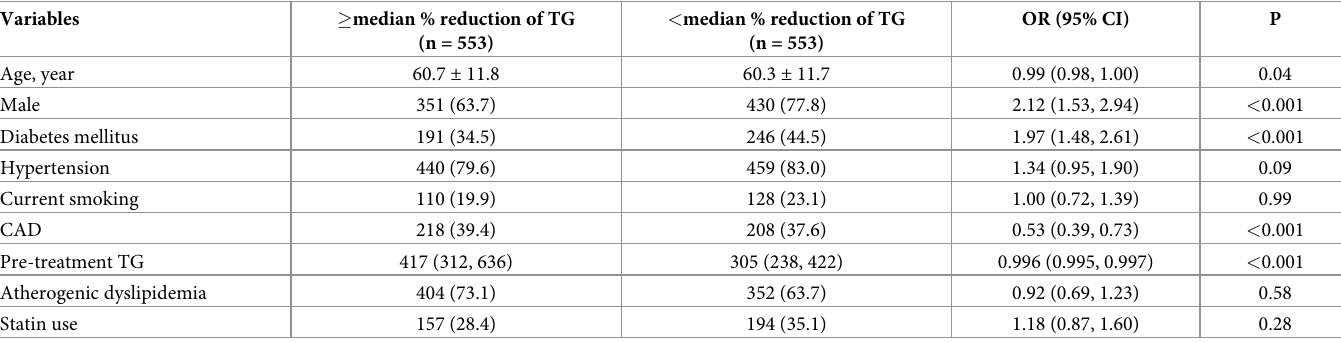
Table 3. Variables associated with TG reduction identified by multiple logistic regression